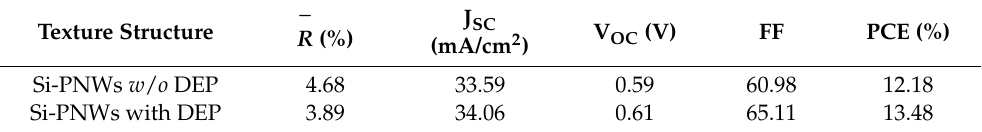
Figure S1. SEM of different AgNO 3 concentrations: (a) 8 mM, (b) 9 mM; Figure S2. The XRD of different structure of samples: (a) planar Si, (b) Si pyramid, (c) SiNWs, (d) Si PNWs; Figure S3. reflectance spectra of different silicon